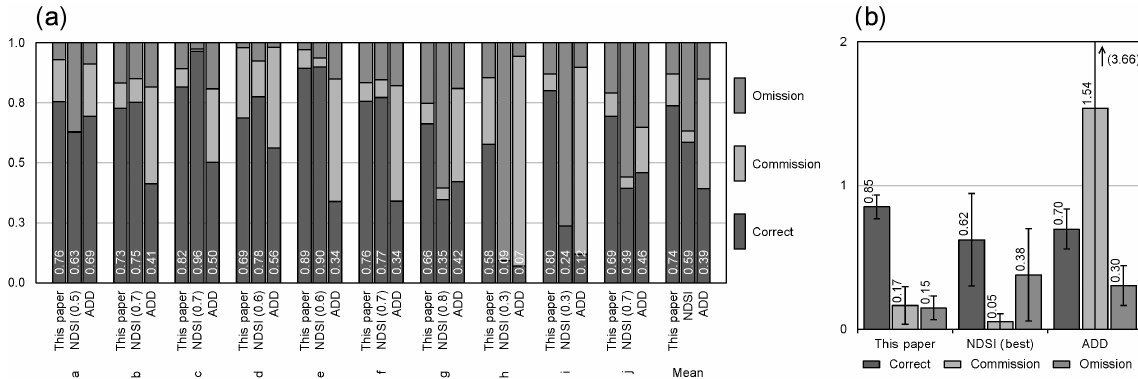
Figure 11. (a) Accuracy assessment data normalised to 1 for correctly classified pixels and pixels of omission and commission disagree- ments for the images in Fig. 8. Optimal NDSI values used are shown in brackets. Values in columns are the classification accuracy values (Eq. 3). (b) Average accuracy assessment values for the three alternative datasets showing the mean values for pixels of correct classification, commission disagreement and omission disagreement for the 10 quality control images (Fig. 8) with error bars at 1SD.